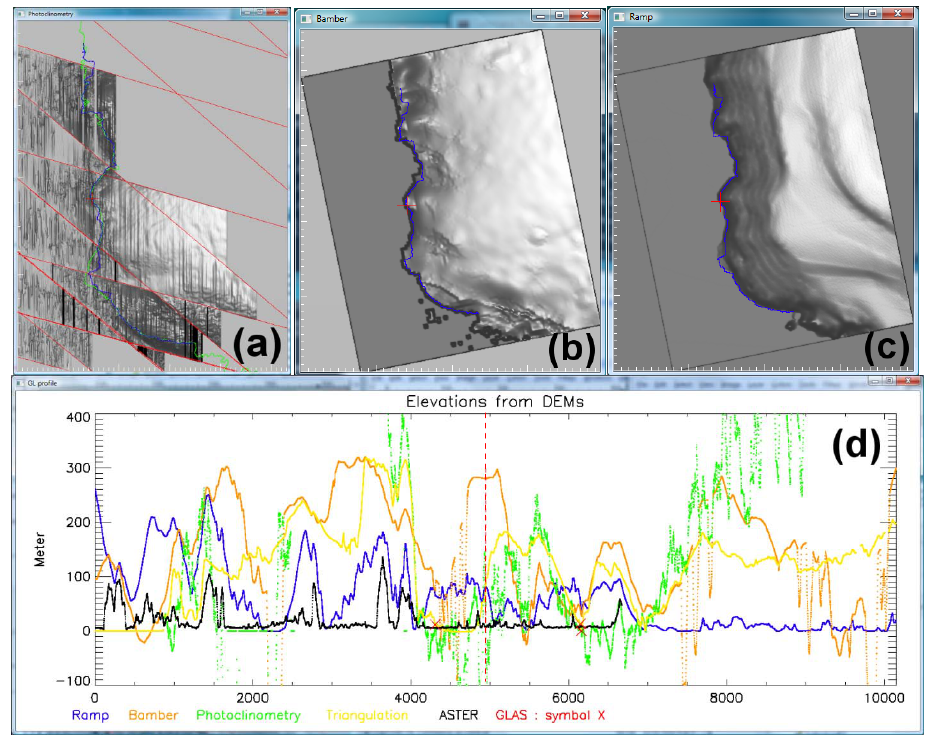
Fig. 5. Sample of screen display for elevation selection operation. (a–c) Shaded relief versions of photoclinometric, altimetric (aka. Bamber, 2009) and Radarsat DEMs, respectively, rotated and illuminated to match the original illumination of the Landsat sub-image. Blue line is the ASAID grounded ice boundary; green line is the MOA “grounding line”. Red “+” symbols correspond to position of vertical dashed red line in lower panel. (d) Elevation profiles extracted from various DEMs indicated by lines of different color (legend below) with red X’s being ICESat GLAS elevation values positioned where the ICESat profiles crosses the grounded ice boundary. Horizontal axis is in units of 15-m pixels. Vertical axis is elevation in meters above sea level.